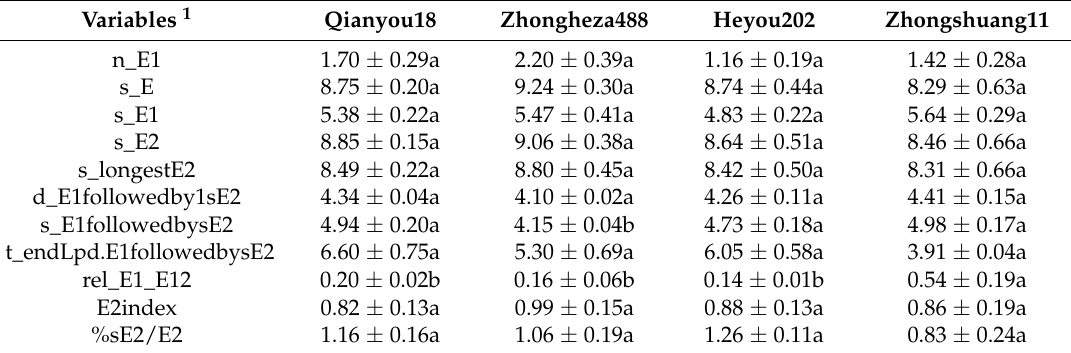
Variables 1 Qianyou18 Zhongheza488 Heyou202